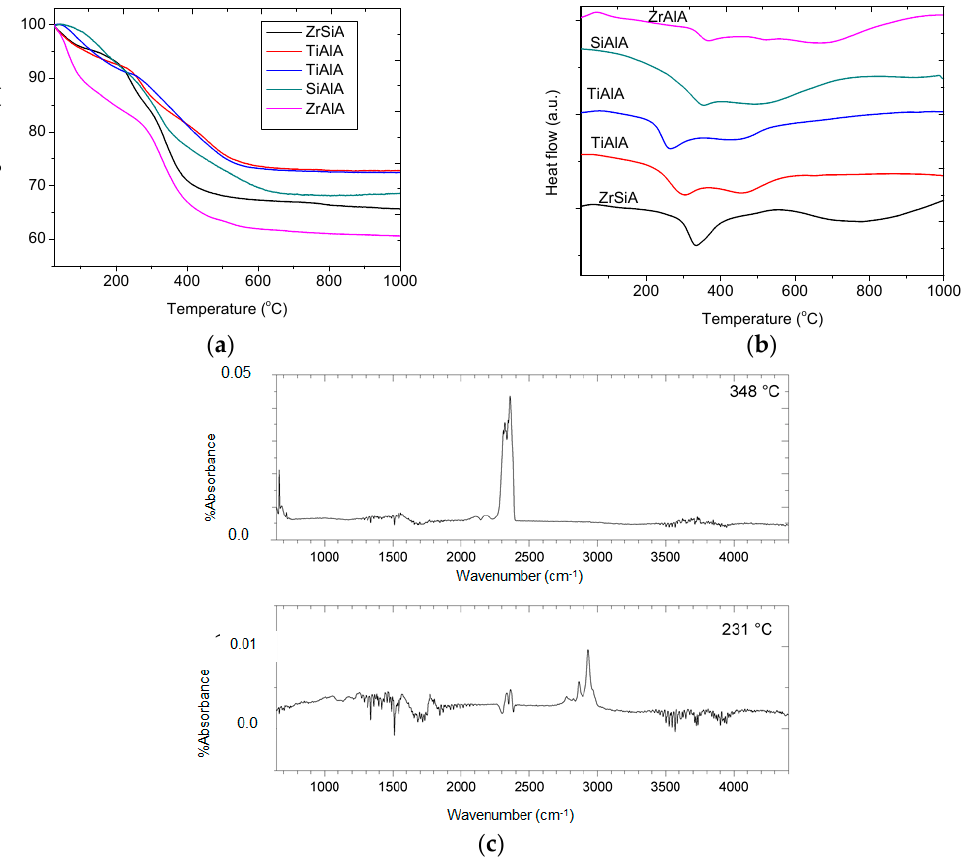
Figure 6. ( a ) Thermogravimetric analyses (TG) and ( b ) DSC plots of as-prepared solids; ( c ) The FIIR curves taken at 231 and 348 ° C for ZrSiA sample.